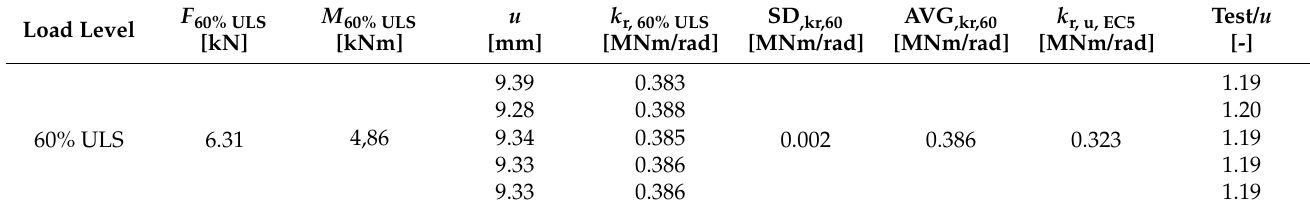
Table 9. Results of quasi-static cyclic testing for Experiment B at 60% ULS.